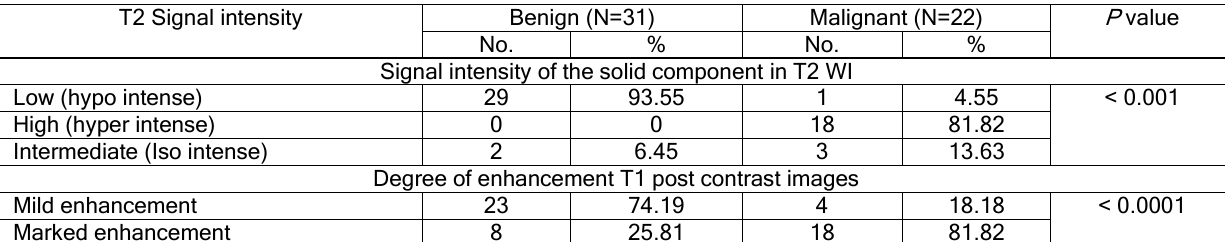
Low (hypo intense)